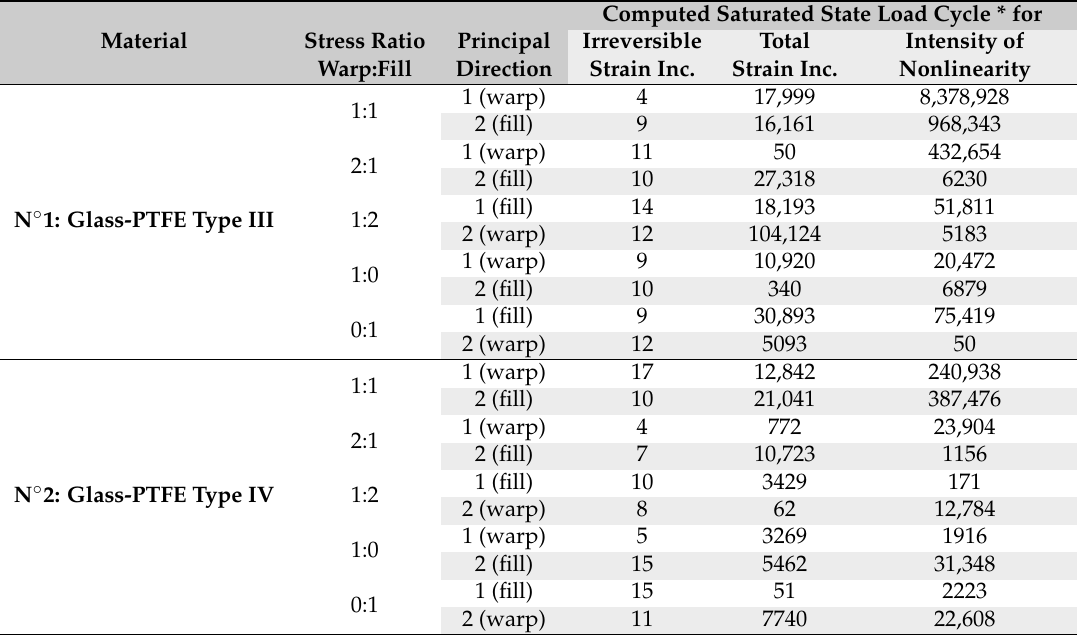
Table 2. Saturated state load cycles for the investigated